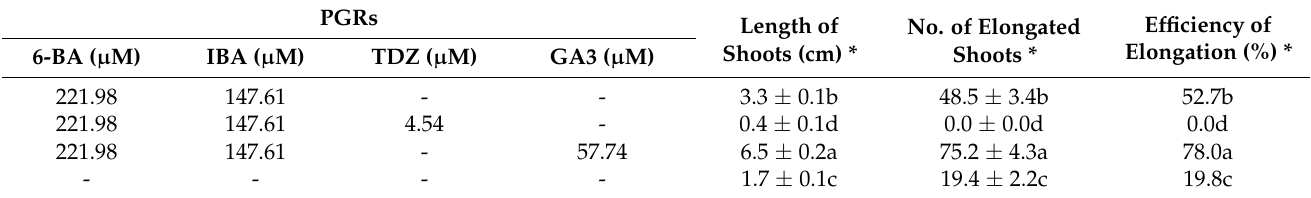
Table 3. Effects of PGRs on further shoot